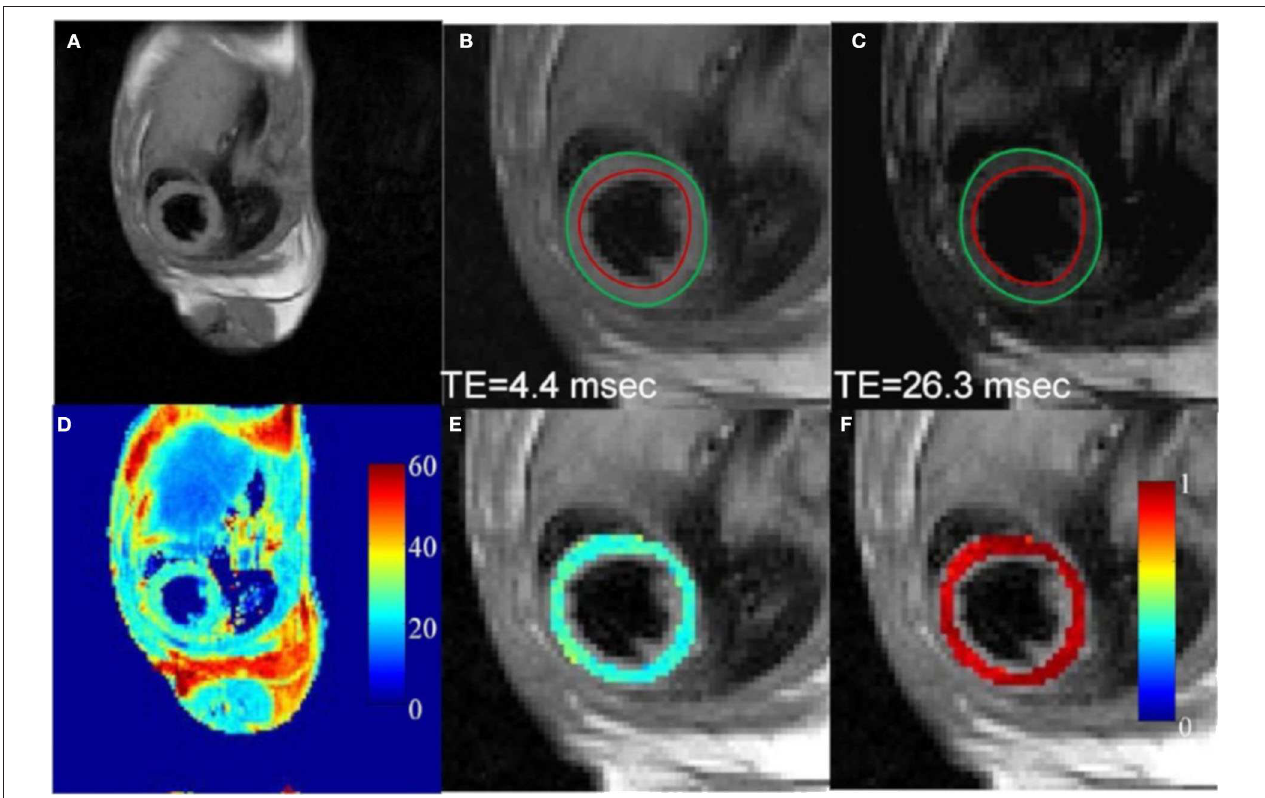
FIGURE 9 | In vivo T2 mapping of a mouse heart using a fully-sampled dataset. (A) Full FOV image of the first echo (TE: 4.4 msec). (B,C) Enlarged images of the heart from the first and sixth echo, respectively. Red and green circles represent endocardial and epicardial contours drawn from the first echo image, respectively. (D) The corresponding T2 map for the whole image. (E) Enlarged T2 map for the mouse heart. (F) Map of squared correlation coefficient for the exponential T2 fitting. Reproduced with permission from Chen et al.